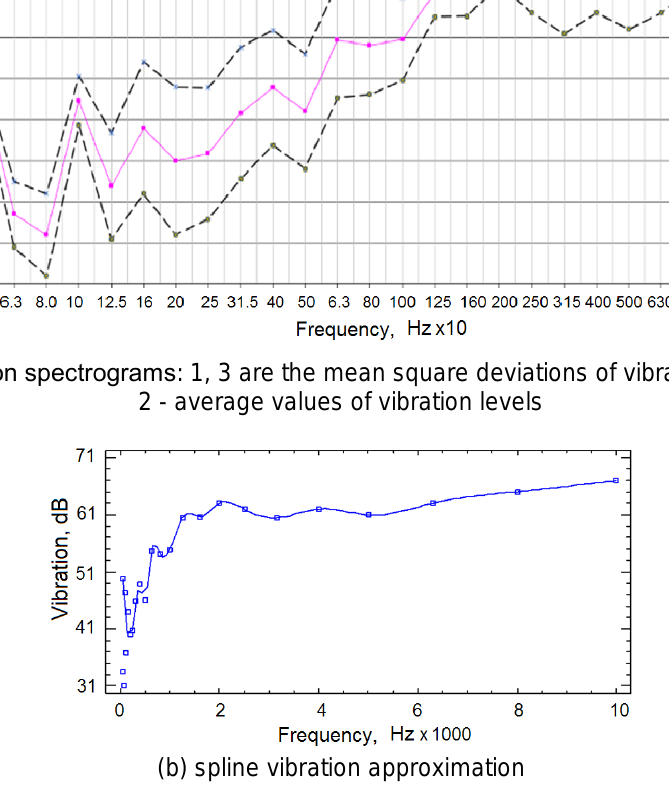
Figure 3. Results of experimental research